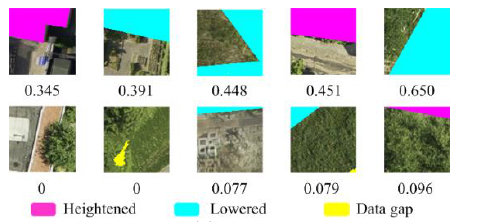
Figure 4. Training samples. (a) Top row: 5 Positive examples. (b) Bottom row: 5 negative examples. The digits below each sample are the ratio of changed pixels in the whole patch.